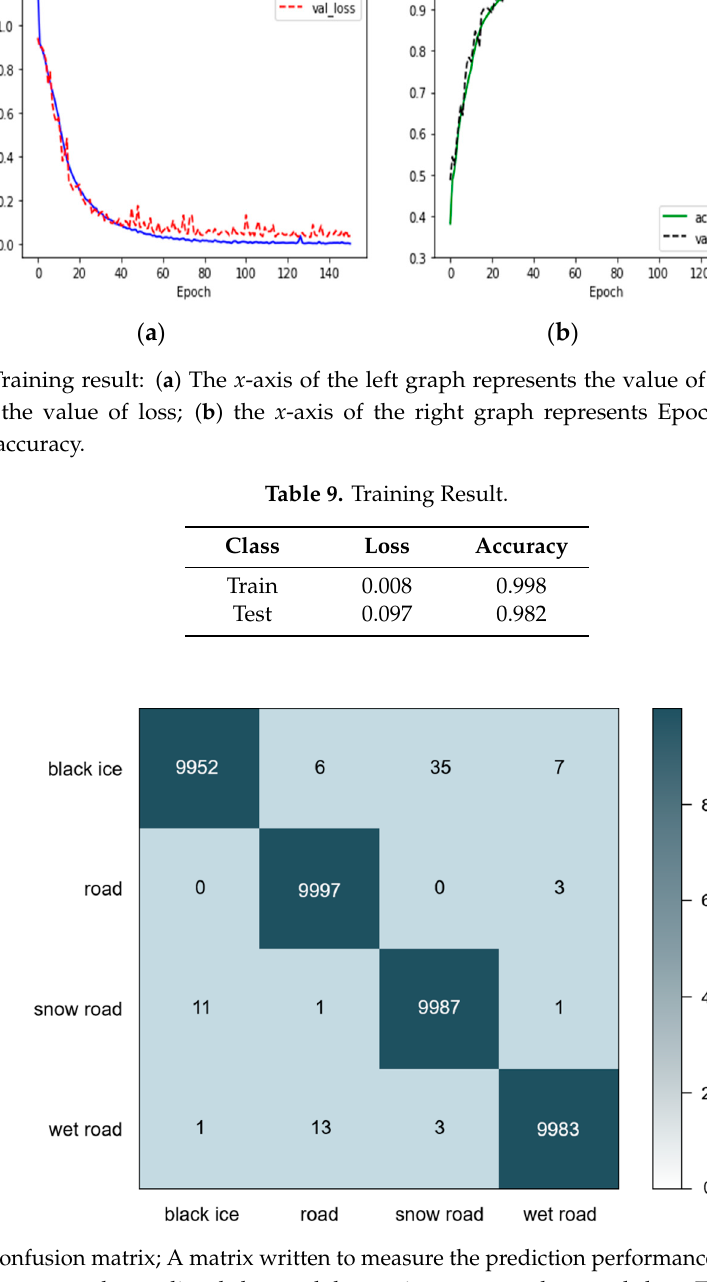
Figure 6. Confusion matrix; A matrix written to measure the prediction performance through training, the x -axis represents the predicted class and the y -axis represents the actual class. The results showed that (x,y) = (snow road, black ice) = 35, (black ice, snow road) = 11, (road, wet road) = 13.